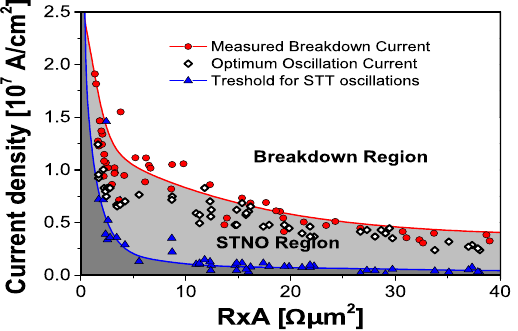
Figure 5. Range of operation of STNOs. Critical current density for STT-induced oscillations J STT (blue triangles), breakdown current density J break (red circles) and current for which the highest Q is achieved (white diamonds). The lines are splines fitted to the data separating the region without STT effects (dark grey), the STNO region (light grey) and the breakdown region (white). The considered sample was S1 with t CoFeB = 2.0